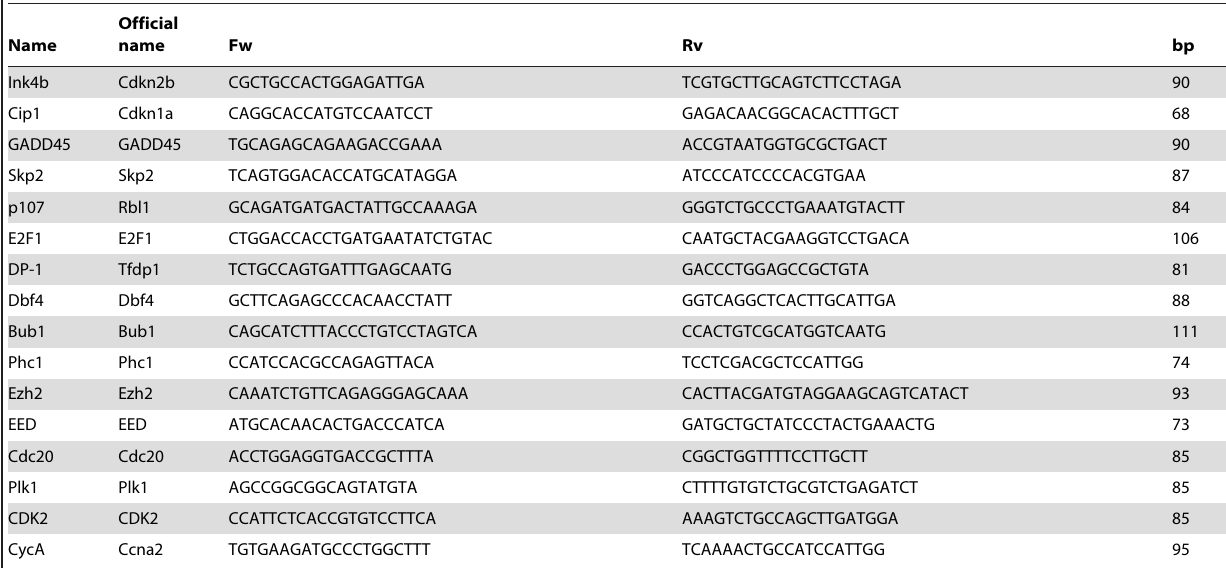
Table 5. Primers used for QPCR